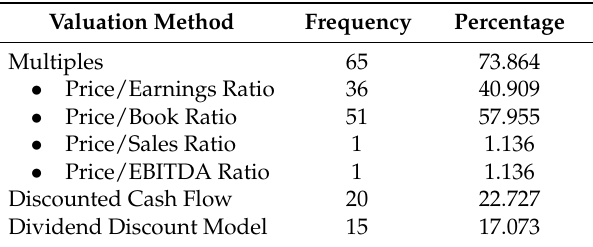
Table 4. Valuation Methods used by